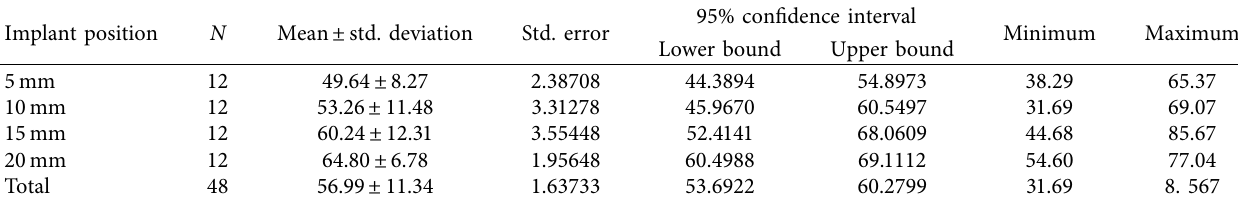
Table 1: Descriptive statistics of different implant